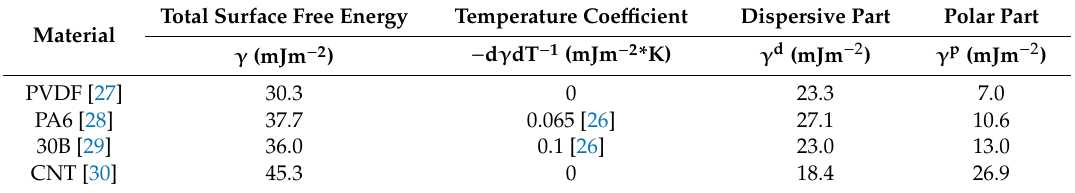
Table 1. Surface free energy of studied polymers and nanofillers at 240 ◦ C.